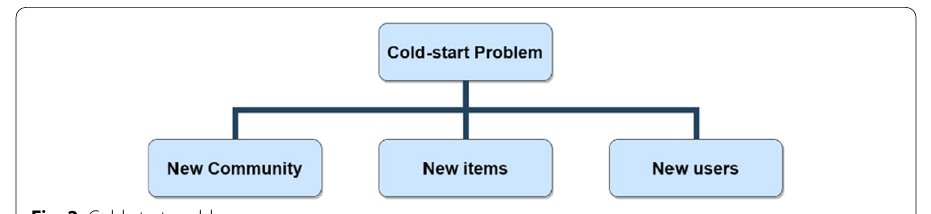
Fig. 2 Cold‑start